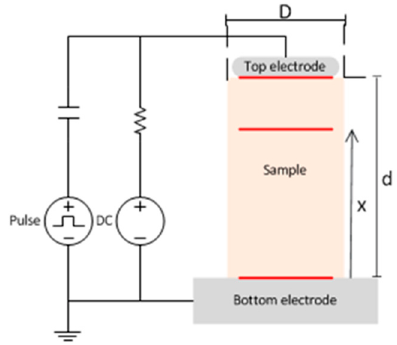
Figure 1. Schematic representation of a PEA measurement for a flat sample. The sample diameter is several times bigger than the height (D >> d) but the scale is modified for representation purposes.